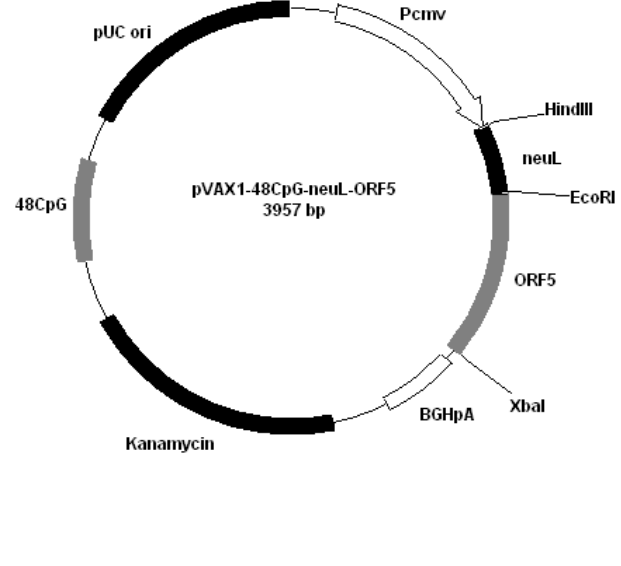
Figure 3. Plasmid